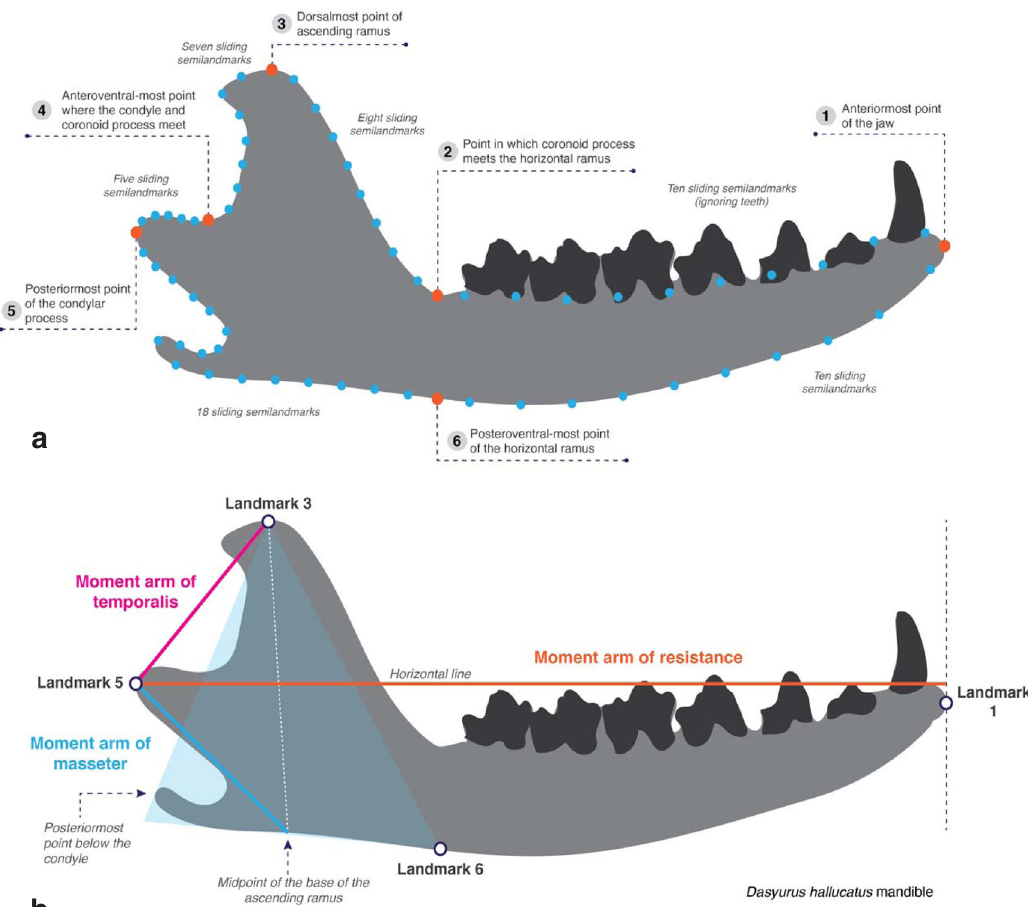
Fig. 2 Data acquired from the jaws of Mesozoic and extant small mammals. a Jaw landmarking regimen used in this study. Modi fi ed from ref. 12 . In orange: six fi xed landmarks; in blue: 58 sliding semi landmarks. b Moment arm measurements taken in this study. Modi fi ed from ref. 19